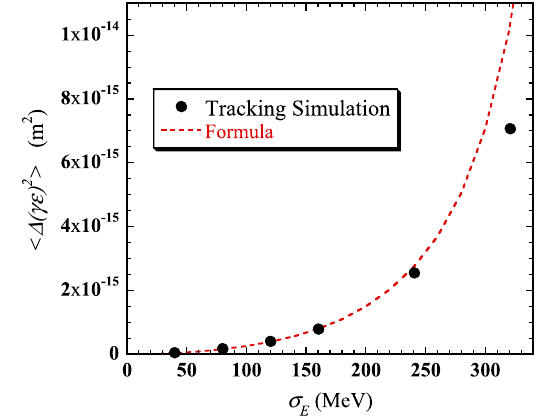
FIG. 4. Average growth of square of emittance [ hð (cid:4)(cid:3) Þ 2 i ] at the linac end, with BPM offset error 50 (cid:10) m (rms) after one to one correction, as a function of the initial beam energy spread. Results of tracking simulation (circle), and the analytic formula.